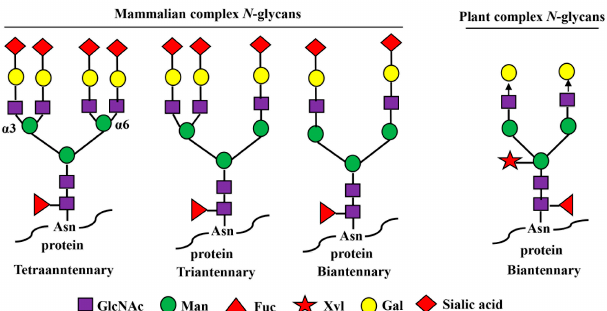
Figure 2. Mammalian- and plant-produced complex-type N -glycans. Complex N -glycans refer to those in which both the α 3- and α 6-linked mannose residues are substituted with GlcNAc moieties. In mammals, the N -glycan chains can be bi-, tri-, and tetraantennary, and the GlcNAc residues in each glycan chain are further extended with β 1,4-galactose residues and terminal sialic acid residues. The sialic acid in humans is N -acetyl-neuraminic acid (Neu5Ac) while other mammals have both Neu5Ac and N -glycolylneuraminic acids (GlcNGc). In plants, their complex N -glycan chains are biantennary, but do not bear β 1,4-galactose and sialic acid residues. The arrow depicts the locations of further expansion of plant complex N -glycans with β 1,4-galactose residues by overexpression of human β 1,4-galactosyltransferase gene ( GalT